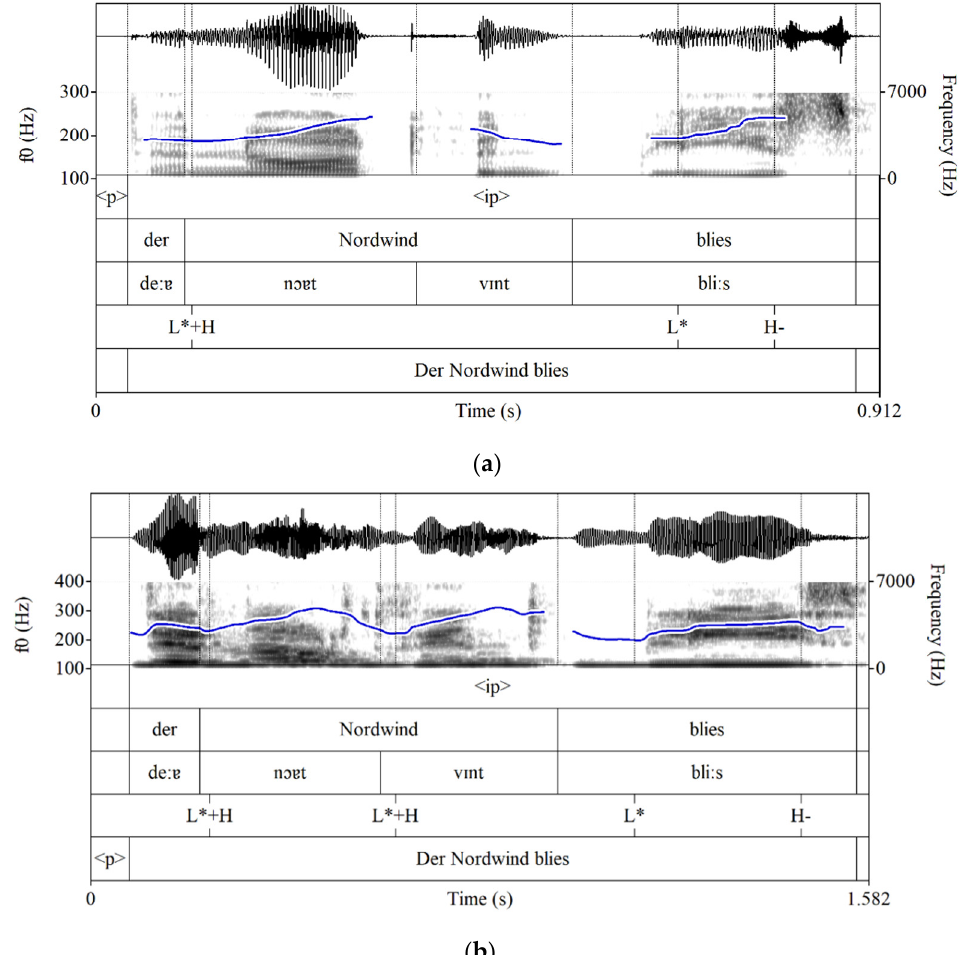
Figure 3. The phrase der Nordwind blies (‘the North Wind blew’) pronounced by ( a ) a native German speaker without stress clash and ( b ) a Bulgarian speaker of German with stress clash.